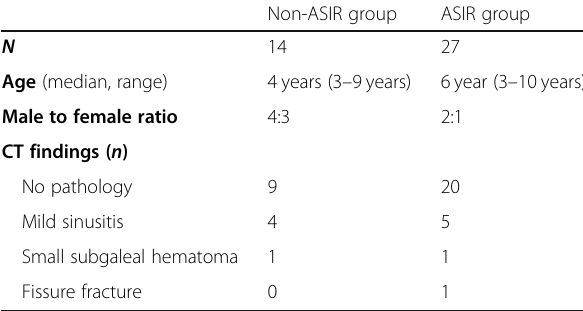
Table 2 patient demographic characters and CT findings ( n =